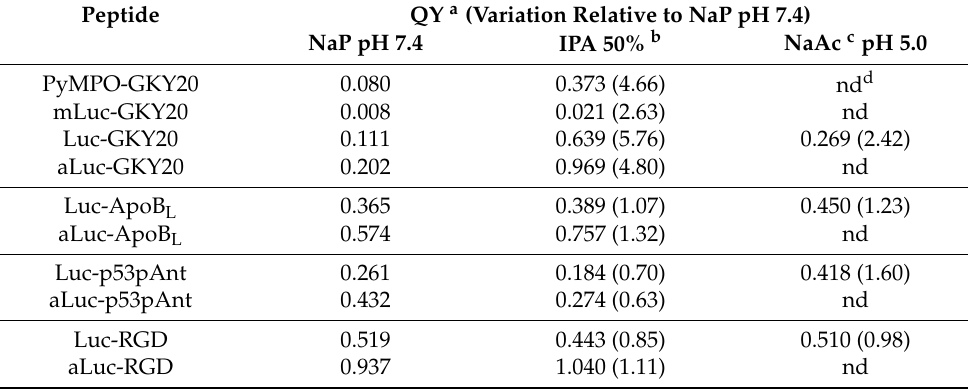
Table 2. Relative quantum yield of the labeled